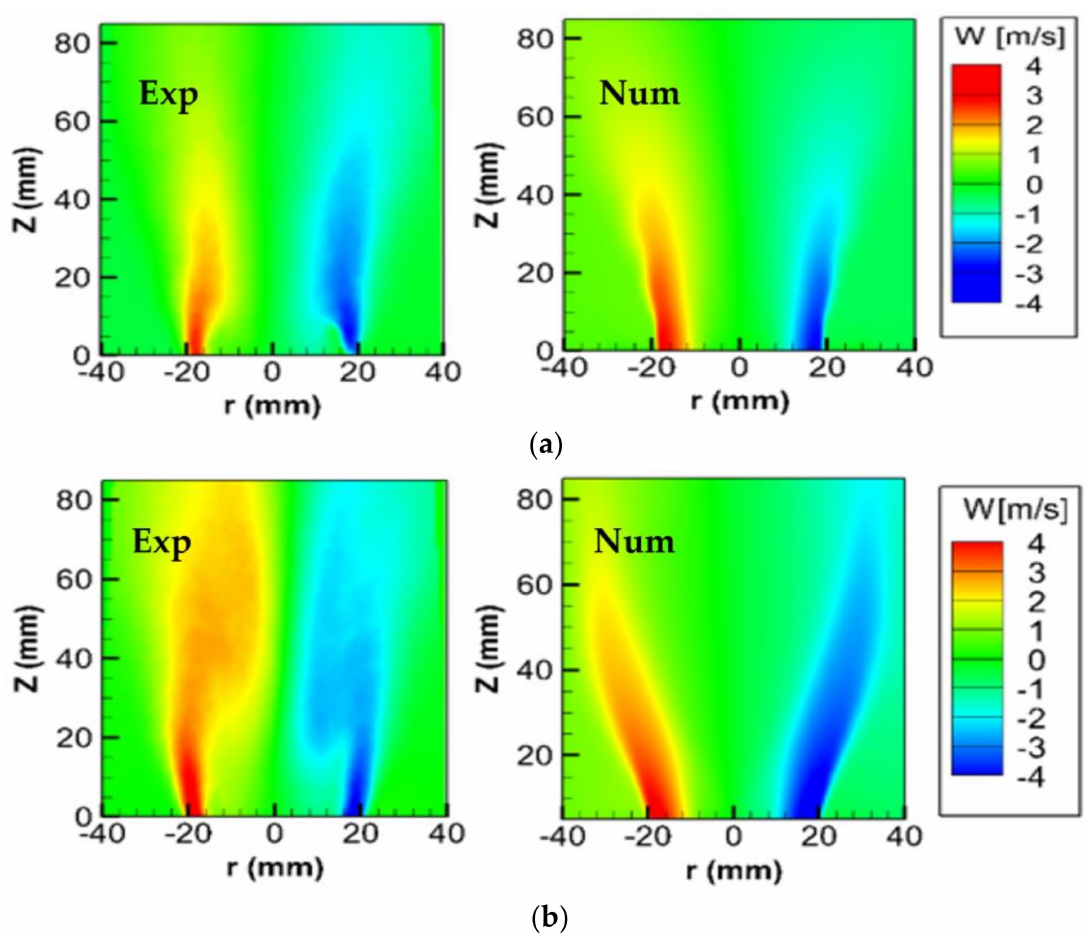
Figure 6. Obtained numerical contours of the tangential velocity compared to experimental data for non − reacting and reacting cases; ( a ) non − reacting case; ( b ) reacting case.